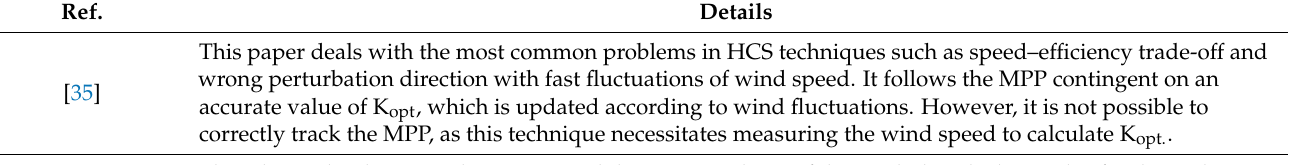
Table 1. Literature review of recent HCS step size